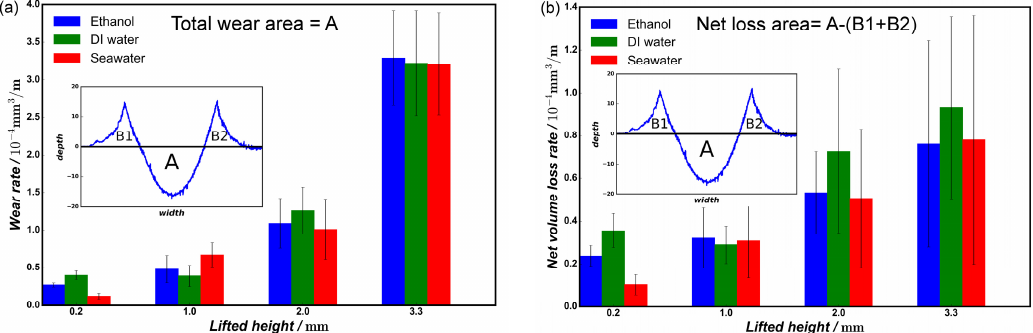
Figure 2. ( a ) Wear rate comparison at various impact heights; ( b ) Net volume loss comparison at various impact height. Ethanol, deionized (DI) water and seawater were used to vary corrosivity. The error bar stands for one standard deviation of three repeated results. The embedded small figure represents the cross section of the round wear track.